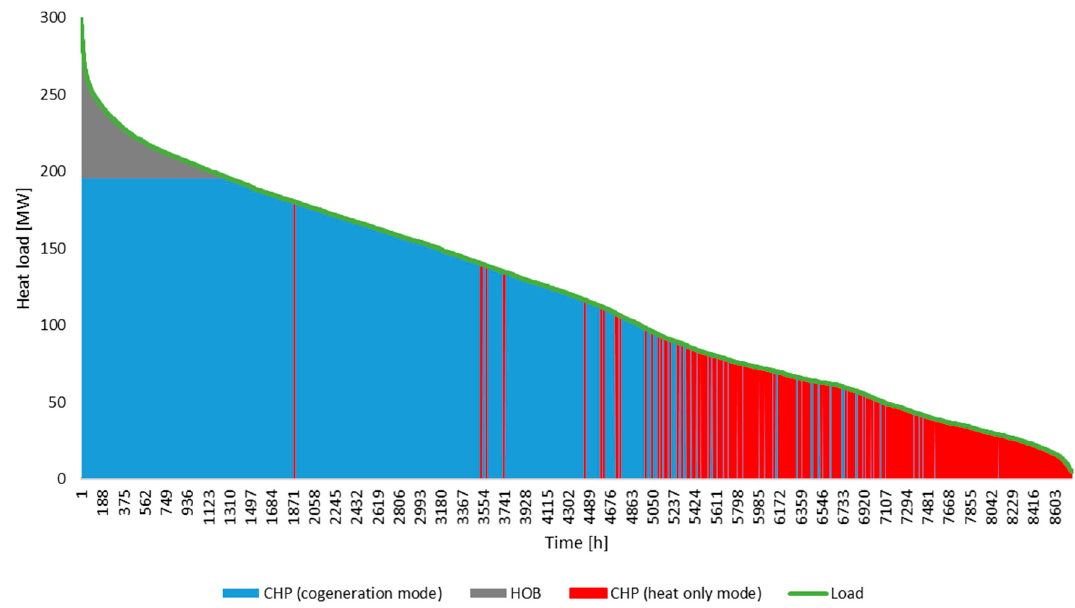
Figure A2. Heat load curve in the reference case without storage in the system.